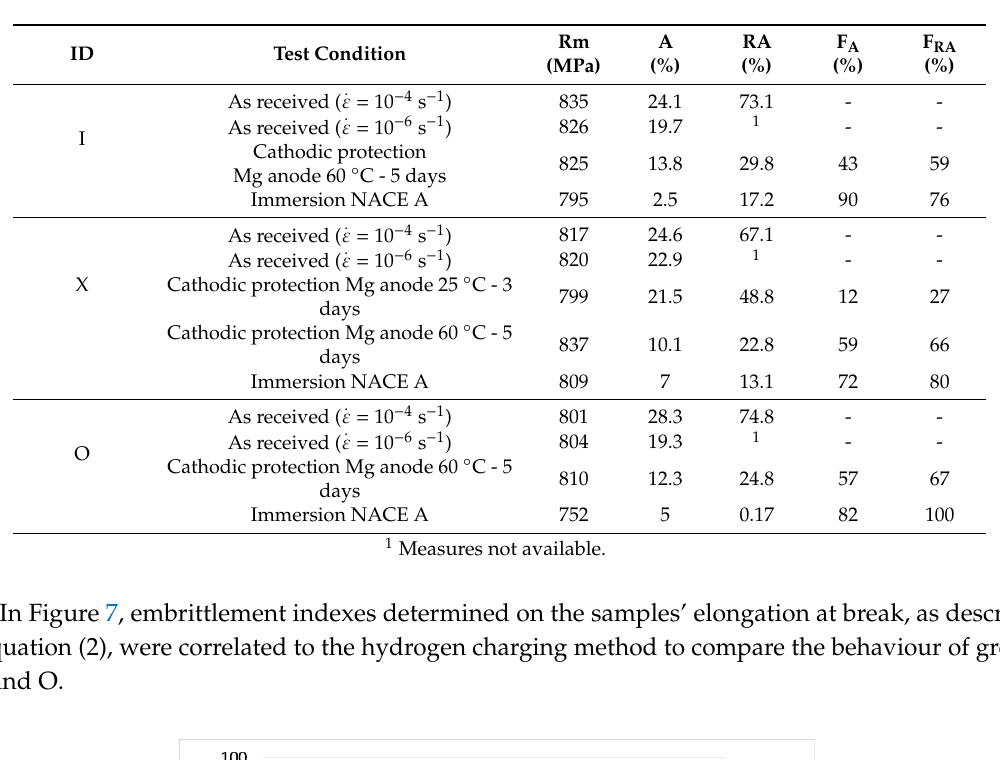
Table 4. SSR test conditions and results.